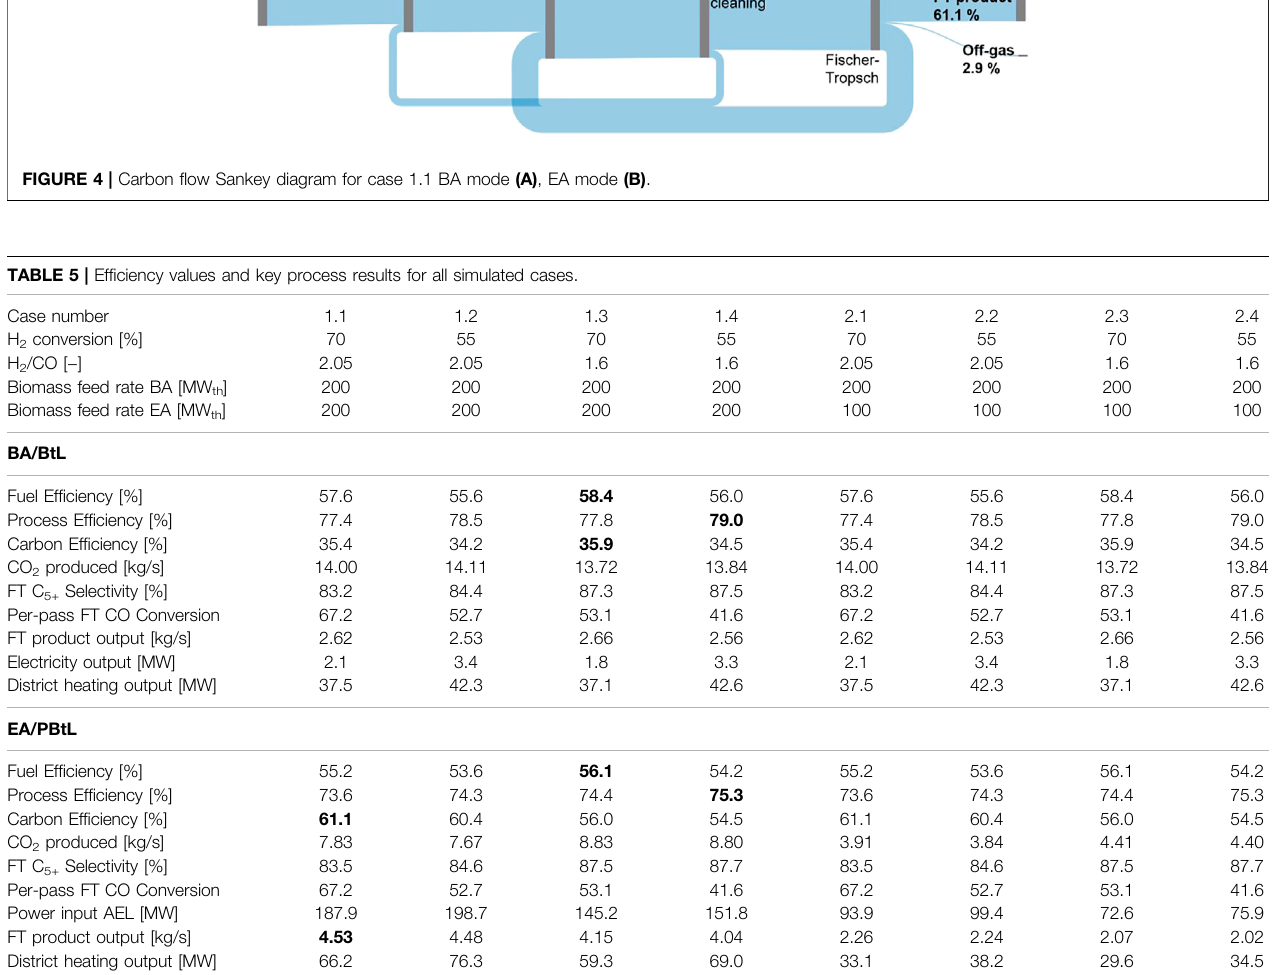
Bold values signify best process performace within case